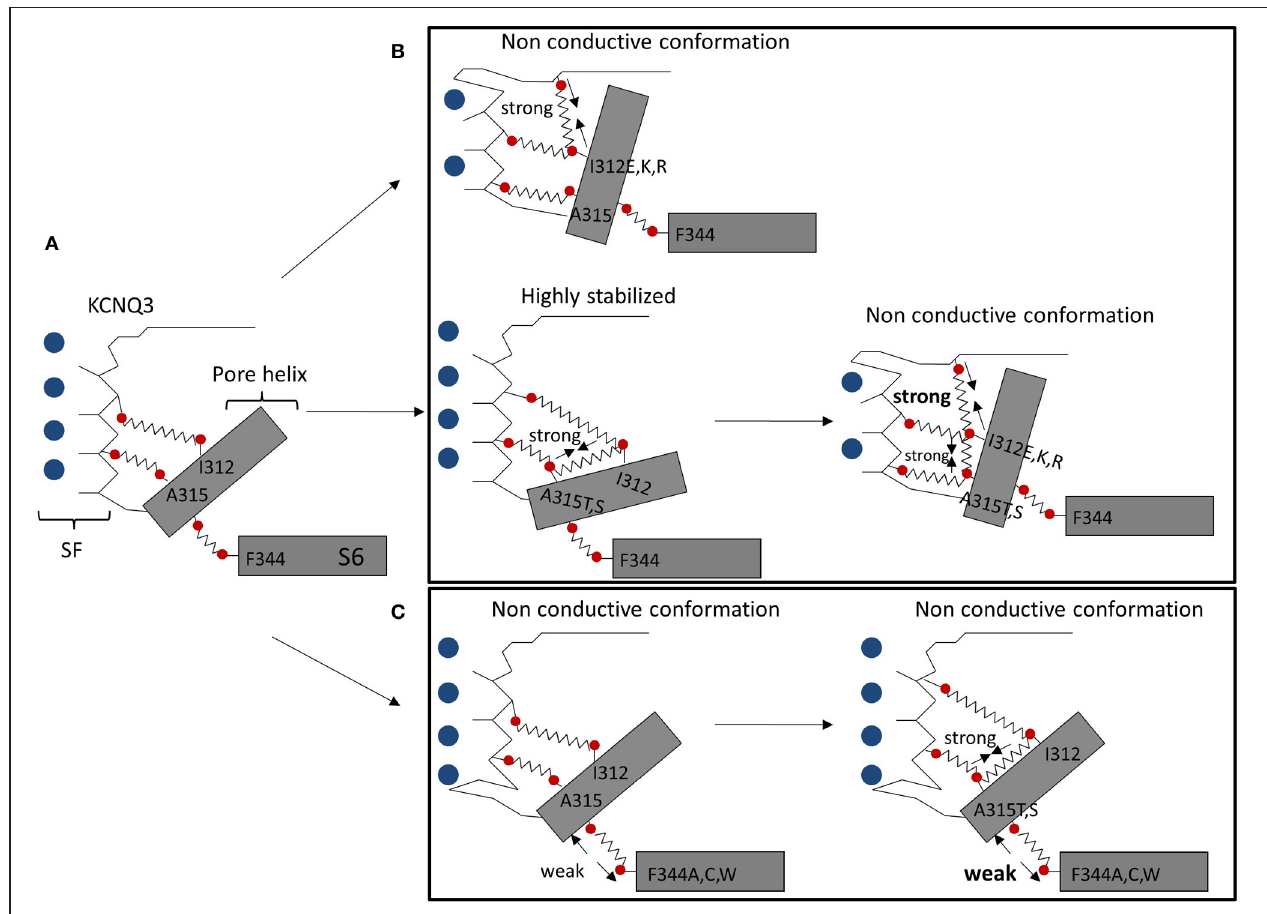
FIGURE 1 | Networks of interactions in the pore region controlling KCNQ3 gating. Shown is a schematic representation of the pore region of wild-type KCNQ3 (A) . Shown are structural rearrangements resulting from